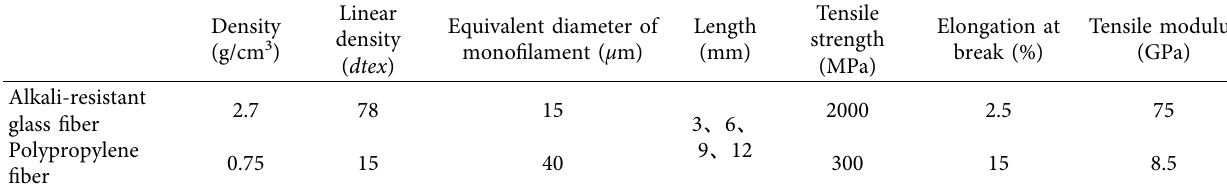
Table 1: The physical and mechanical properties of